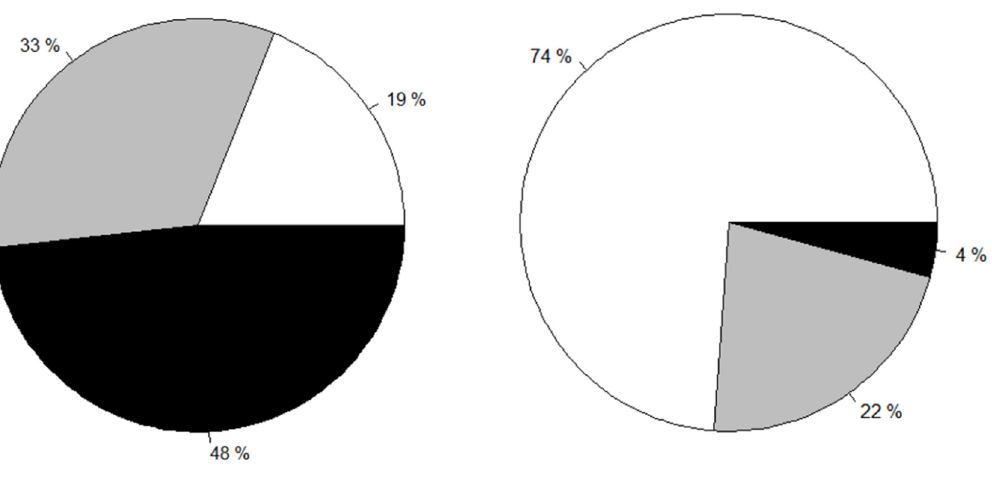
Figure 1. A comparison of Internet hate exposure frequency among participants in two studies. For better visibility, the data were clustered into three bundles. Chart legend: black bundle—categories from “once a week” to “every day”; grey bundle—categories from “a few times a year” to “a few times a month”; white bundle—categories from “never” to “once a year”.